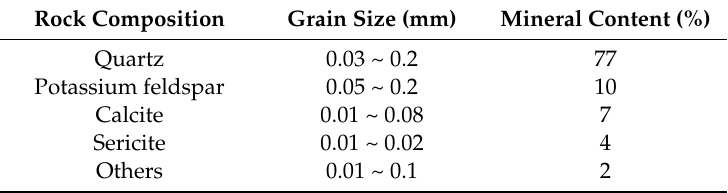
Figure 1. Polarized light micrographs of sandstone specimen: ( a ) plane polarization light (PPL); ( b ) cross polarization light (CPL). (Note: The letters Qz, Kfs and Cc represent quartz, potassium feldspar and calcite, respectively). Table 1. Mineral composition and grain size distribution of sandstone specimen.